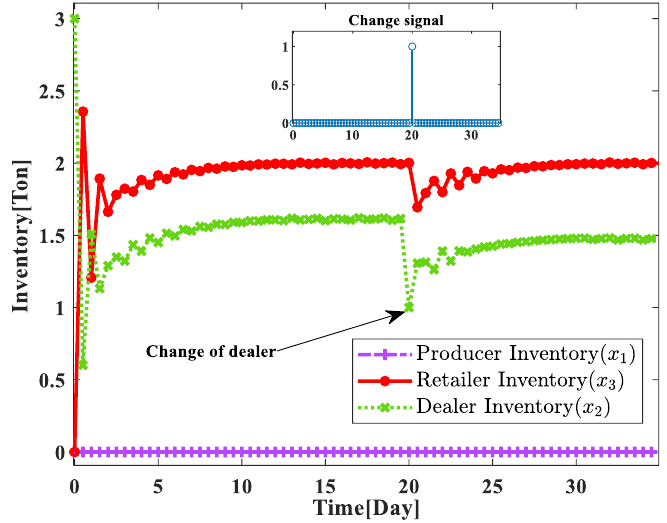
Figure 12. Supply chain system inventory status with optimization